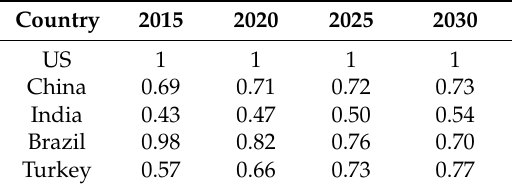
Table 5. Purchasing power parity (local currency/USD)